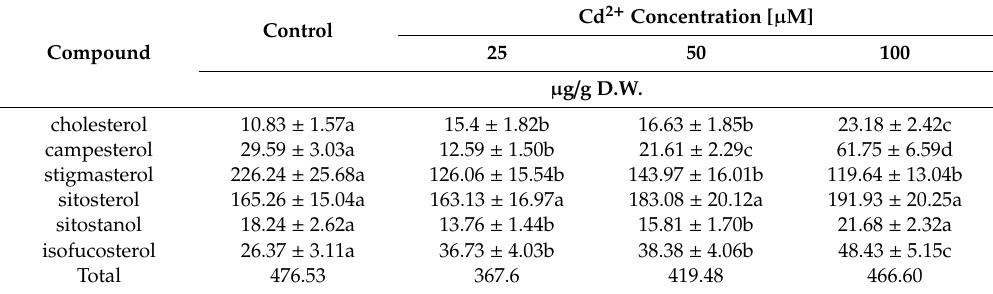
Table 4. The content of sterols in line CH2 hairy root tissue after treatment with Cd 2 + ions.